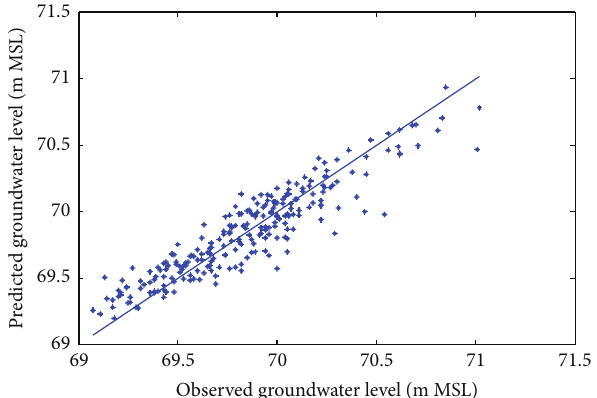
Figure 11: Scatter plots of observed and predicted groundwater lev- els using an ANN trained with the Levenberg–Marquardt algorithm (Pp 928).